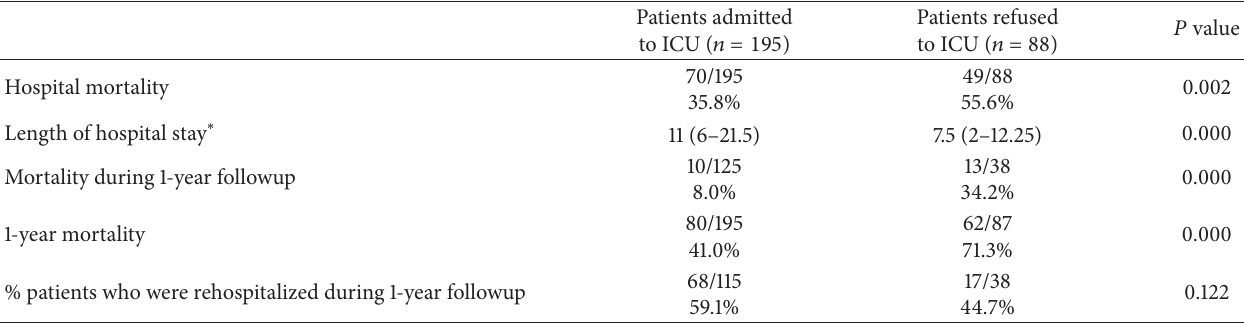
Table 3: Outcomes of patients who were candidates to